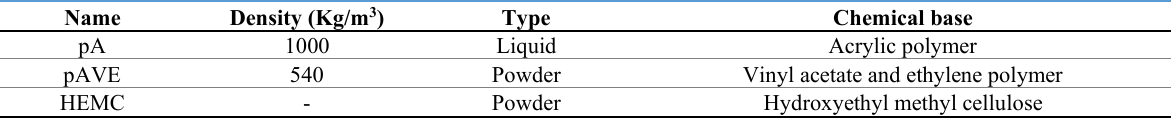
Table 3. Admixture’s